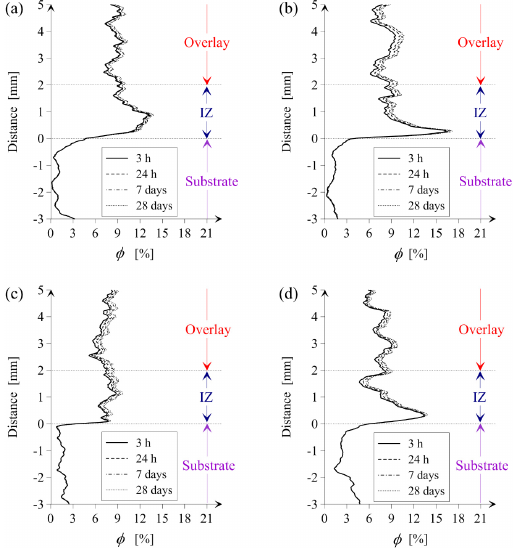
Figure 6. The microporosity φ as a function along a sample height obtained within the IZ between the overlay made of cement mortar and the existing concrete substrate obtained using the micro-CT method at different moments of overlay hardening for Samples ( a ) T1; ( b ) T2; ( c ) T3; and ( d )